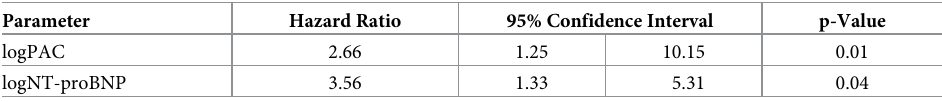
Table 2. Multivariable analysis of revised parameters of left atrial disease on AF-free